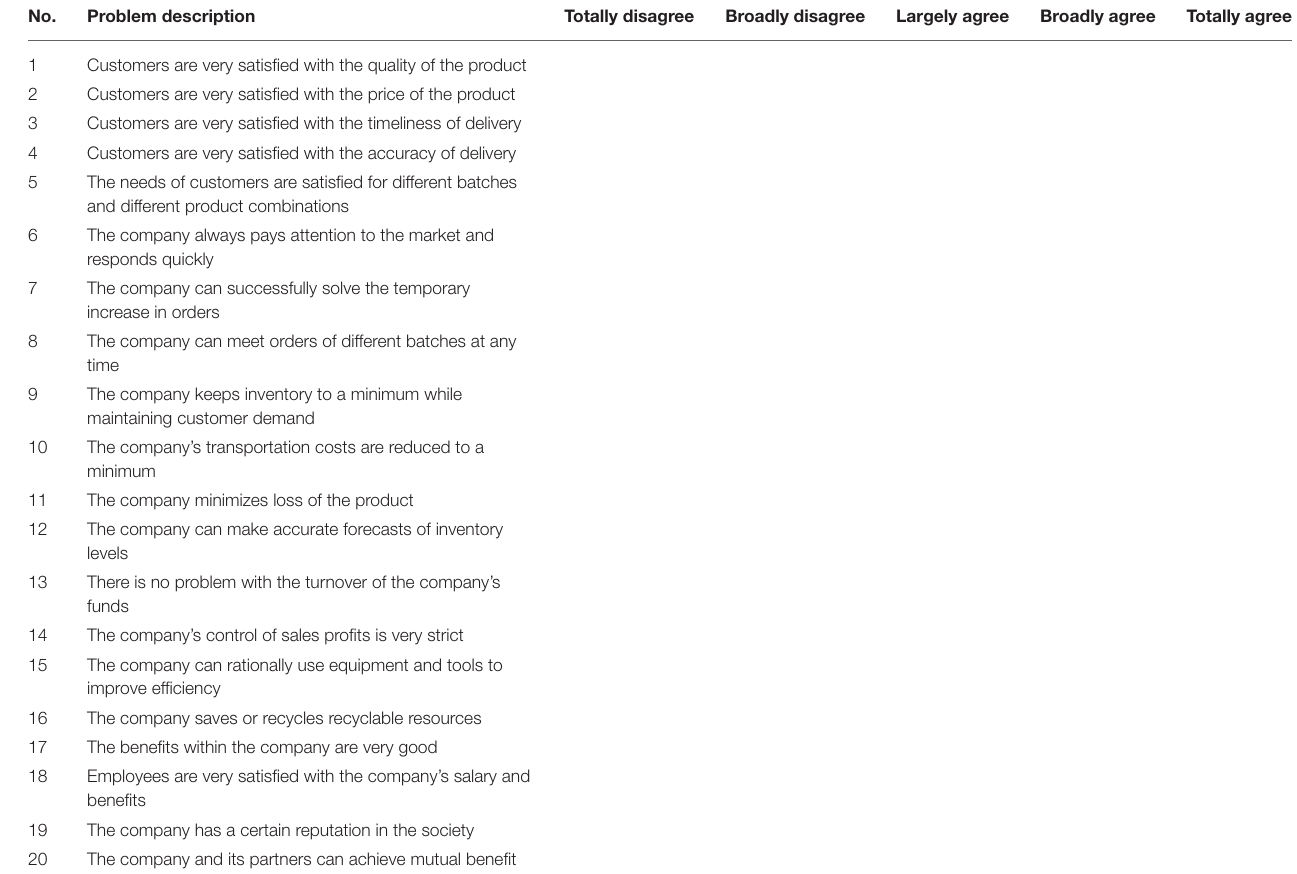
TABLE 1 | Questionnaire of self-evaluation indicators of the green supply chain.